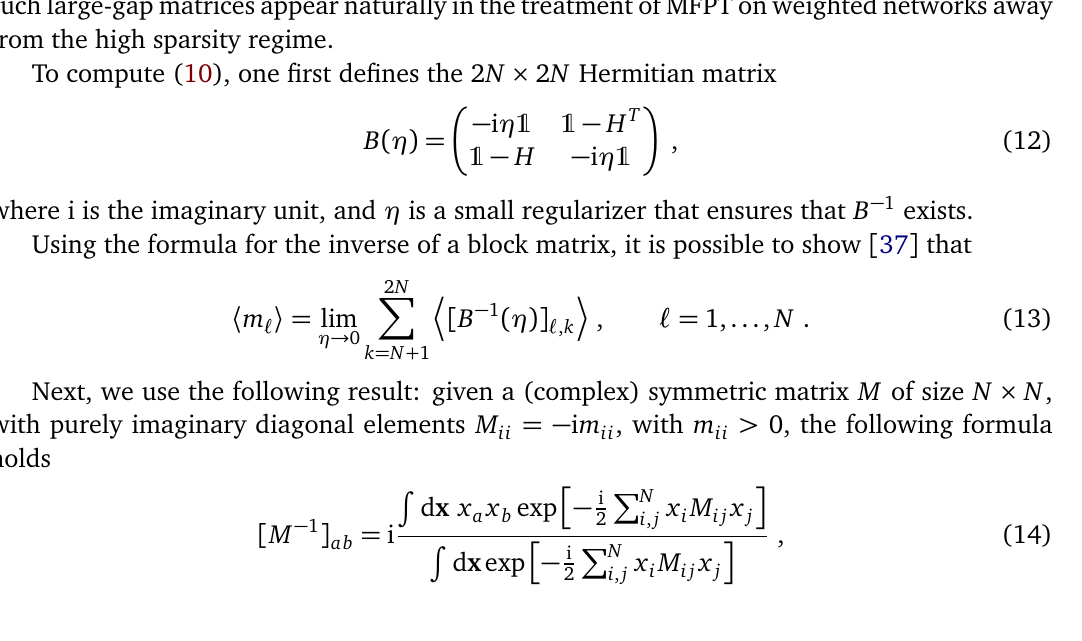
Figure 1: Left: Spectrum of a typical instance of a N = 500 Gaussian matrix (with σ ∼ O ( 1 / N ) ) plus a rank-1 deformation of the form (7). The red line encloses (cid:112) N ∼ O ( 1 / N ) , while an isolated outlier at λ the circle of radius r N visible. Right: Spectrum of a typical instance of a N = 500 Gaussian matrix (with (cid:112) σ ∼ O ( 1 / N ) ) plus a rank-1 deformation of the form (7). The red line encloses N ∼ O ( 1 ) , which swallows the would-be outlier at λ the circle of radius r N } have been used to produce the two altogether. The same constant values { z ,..., z N 1